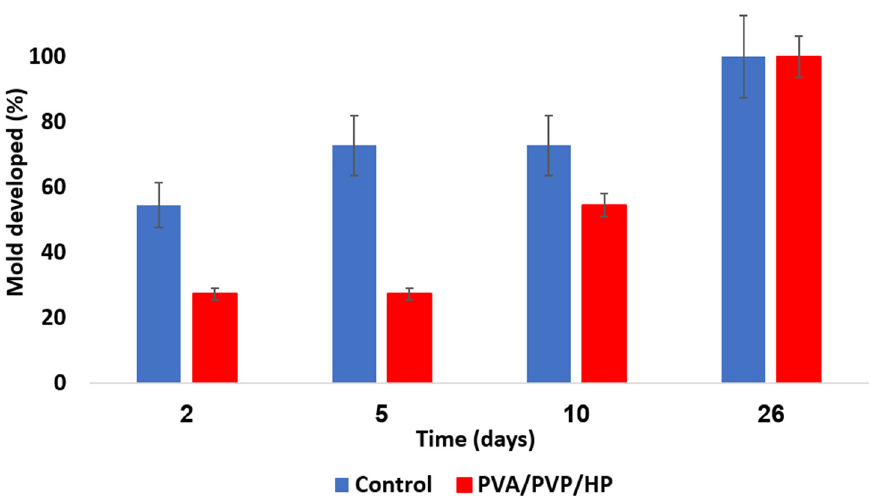
Figure 10. Mold growth rate over several days. Uncoated PE sheets (blue) are a control. PVA/PVP/HP hydrogel coated sheets (red) contain an entrapped anti-mold component.